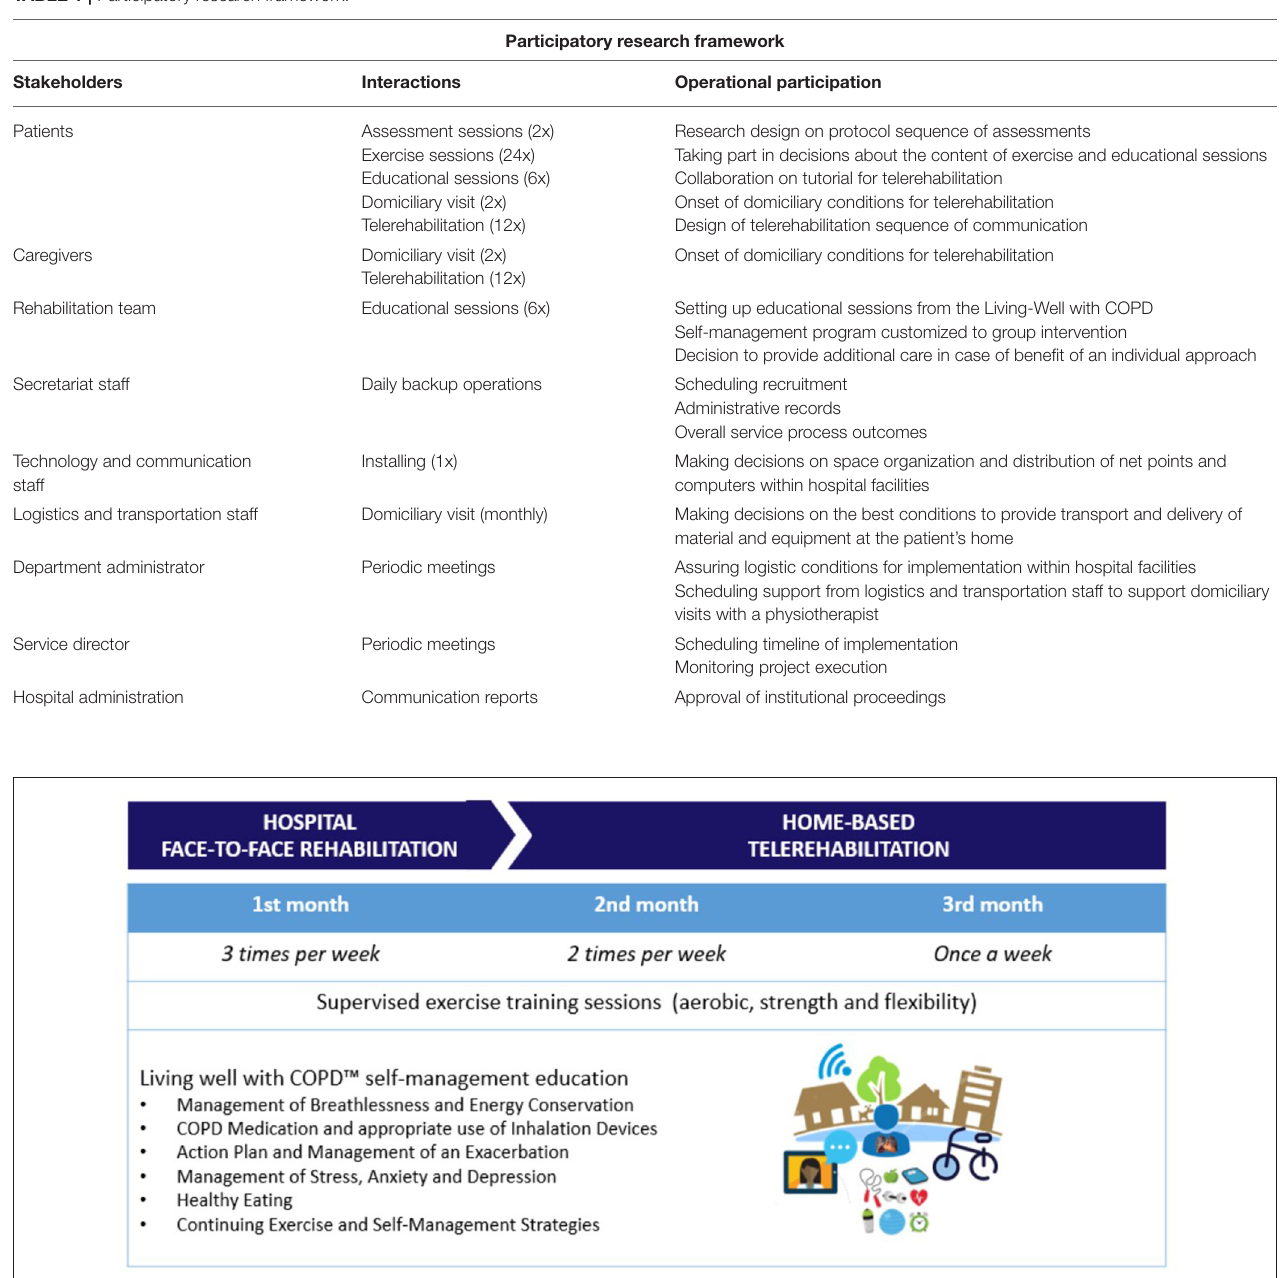
balls, dumbbells, and elastic bands for three exercises with three sets of 10 repetitions with breathing control and oximetry monitoring during pauses between sets to monitor SpO 2 > 90%. Flexibility training included four global muscle chain exercises on stall bars (posterior, anterior, and lateral) and specific stretching exercises according to the selected ergometers during the aerobic training (quadriceps, hamstrings, calf, biceps, triceps, pectoralis,